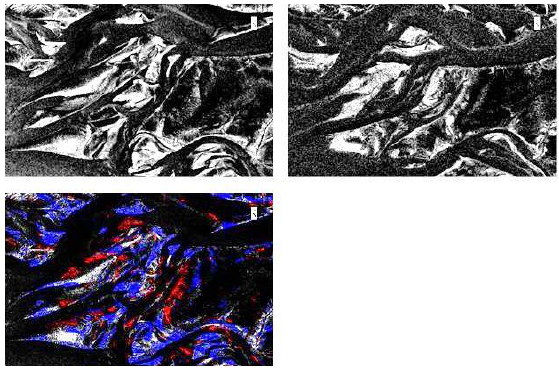
Figure 9. Subsections of the two SAR images used for the derivation of the temporal coefficient shown in Figure 8 (white rectangle). Upper left: Radarsat-2 SAR image of October 17, 2009; upper right: Radarsat-2 SAR image of September 5, 2013; lower: temporal coefficient, with the older SAR image underlying